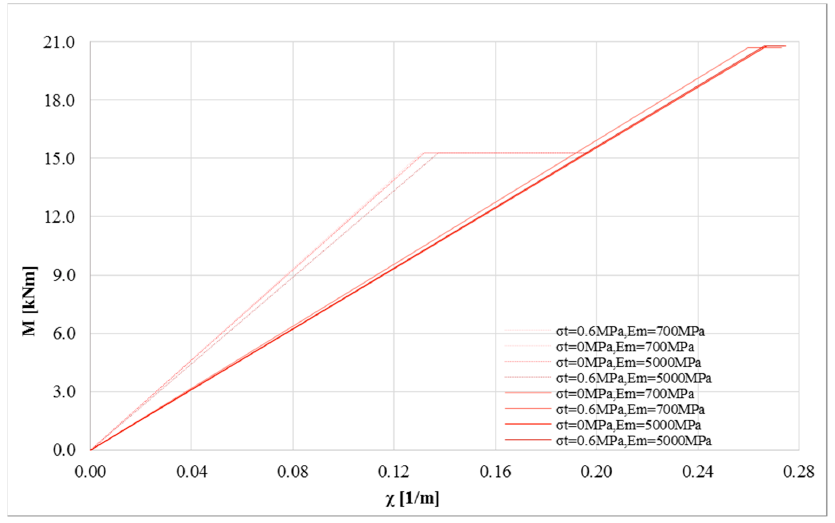
Figure 10 . Bi-linearized M- χ curves: P = 0 N, σ 0 = 8 MPa, σ t = 0 and 0.6 MPa, E m = 700 and 5000 MPa for linear (solid lines) and bi-linear (dotted lines) relationships for the strengthening system (basalt fiber).